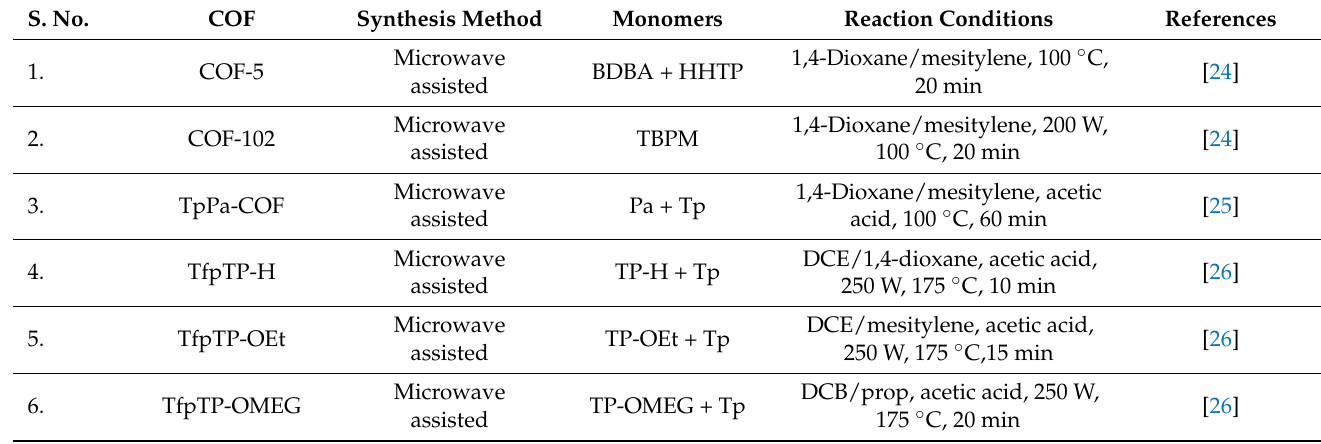
Table 2. COF type, synthesis method and favorable conditions for its